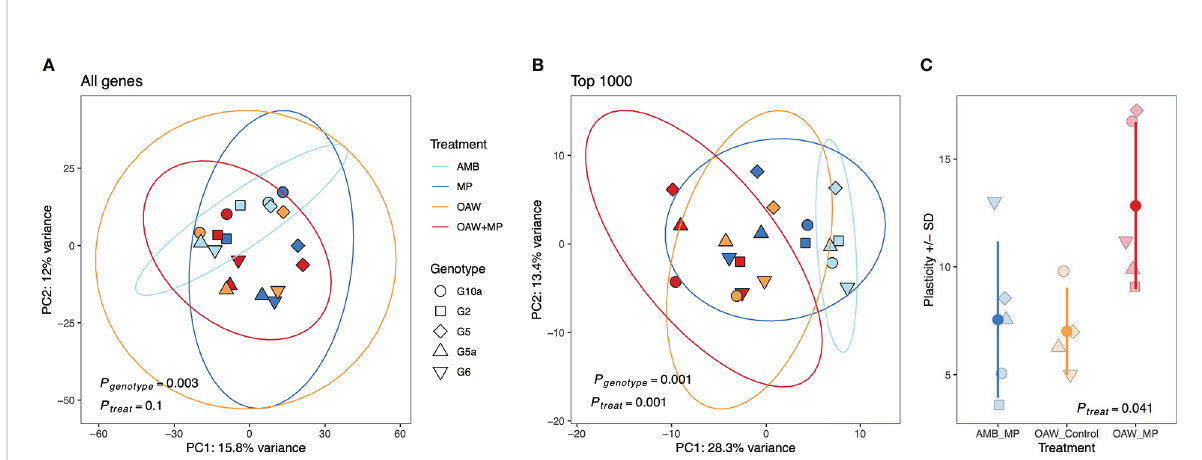
FIGURE 3 Transcriptomic responses to local and global stressors in Acropora cervicornis. (A) Principal component analysis (PCA) of rlog -transformed counts for all genes and, (B) the top 1000 differentially expressed genes by treatment in DESeq2 . PERMANOVA results for the effect of genetic background (genotype) and treatment are included. (C) Gene expression (GE) plasticity +/- standard deviation (SD) estimates calculated from PC distances from (B) where each point is the distance that genotype moved from its ambient fragment (AMB) in PC space.